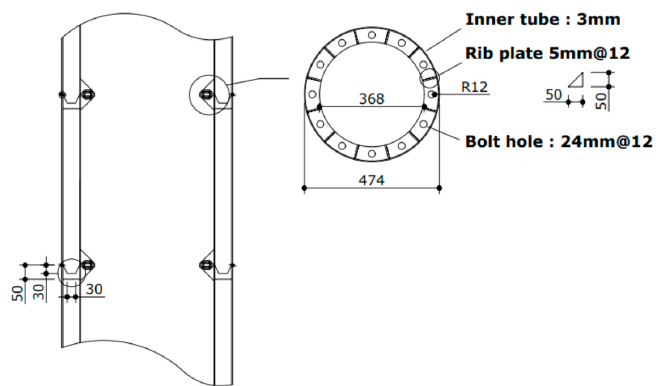
Figure 10. Bolted–welded with shear key connector (Type-W).